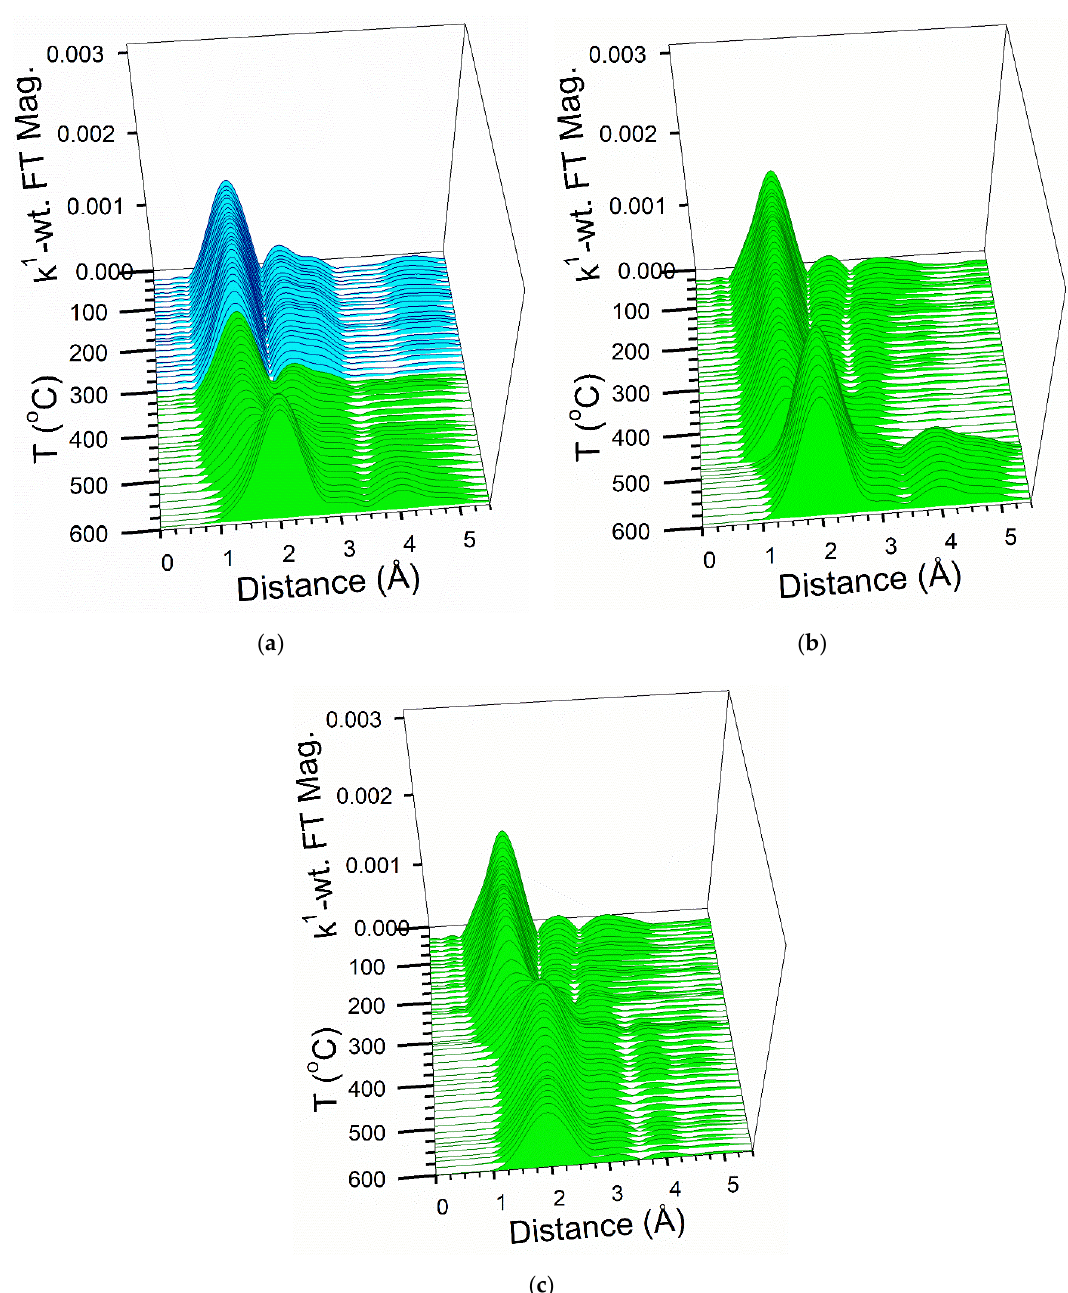
Figure 7. TPR-EXAFS profiles of ( a ) calcined 12% Co/SiO 2 from cobalt acetate, ( b ) uncalcined 12% Co/SiO 2 from cobalt acetate, and ( c ) uncalcined 0.5% Pt-12% Co/SiO 2 from cobalt acetate.